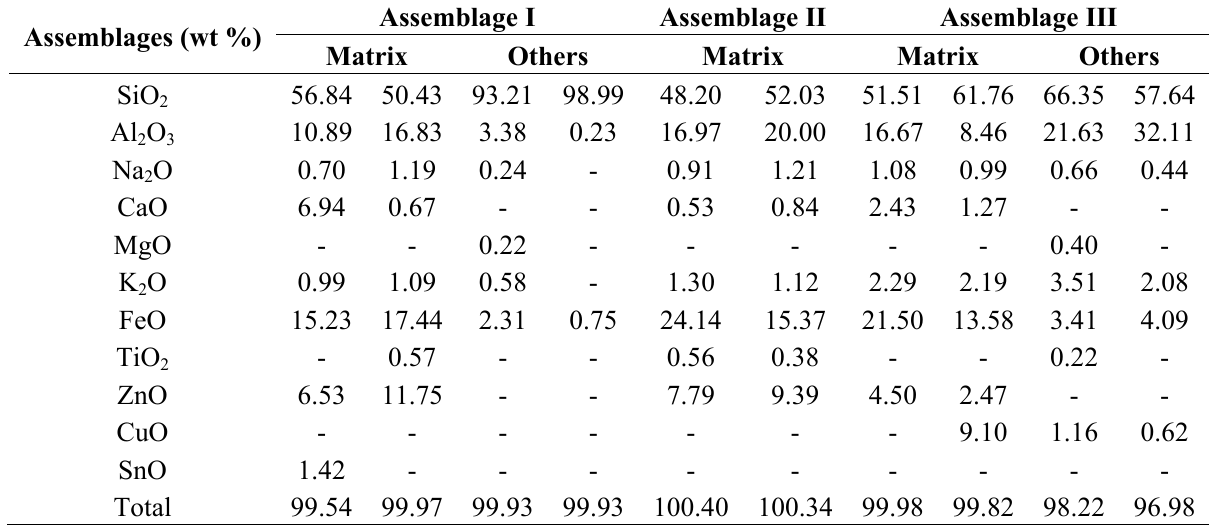
Table 5. Chemical compositions of glass obtained by EDS. Matrix: glass in matrix; Others: Si-rich glassy materials. “-” indicates non-detected.